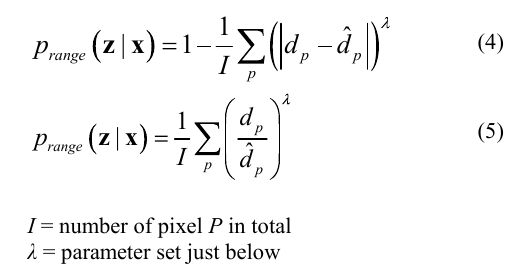
Figure 7. Image of predictive distribution Figure 8. Likelihood of each colour model Range Observation Models: For range observation models, we use a distribution according to a similarity between a shape of predicted ellipsoid and observed 3D points in actuality. For each pixel P included in the ellipsoid, let d ( P ) the distance from observed coordinates to the centre of the ellipsoid O . Let P ' the point that a half line from O to P intersects the ellipsoid, and ˆ ( ) d P the distance from O to P '. We consider two model types as follows: Equation (4) measures a distance (Distance Type) and (5) a ratio (Ratio